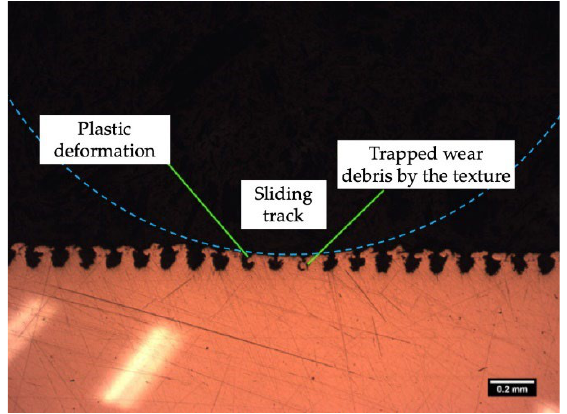
Figure 12. Wear debris trapped by the textured tracks.